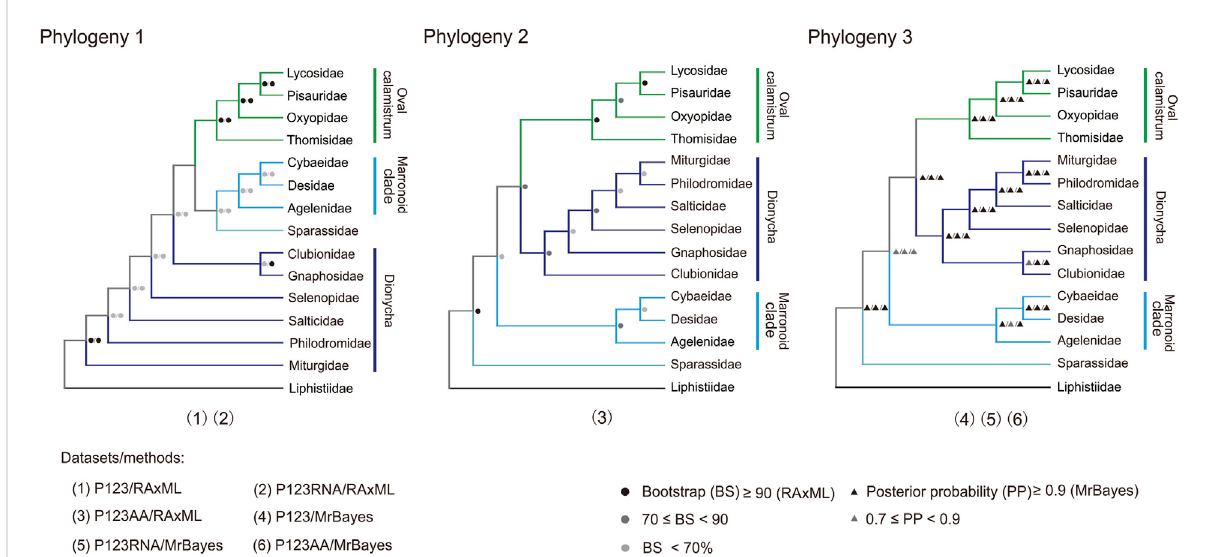
FIGURE 8 Three phylogenies of 14 families in the retrolateral tibial apophysis clade. Phylogeny 1 is summarized: P123 and P123RNA datasets based on RAxML analysis); Phylogeny 2 fromP123AA dataset basedon RAxML analysis; Phylogeny3fromthree datasets basedon MrBayes analysis. P123, with nucleotidesequencesforallcodonpositionsof13PCGs;P123RNA,withP123andthenucleotidesequencesoftworRNAs;P123AA,withtheinferred amino acid sequences of 13 PCGs. Icons on branches are bootstrap values and Bayesian posterior probabilities. Numbers 1 – 6 indicated phylogenetic relationships among the 14 families in the RTA clade obtained with different mitogenomic datasets and analytical